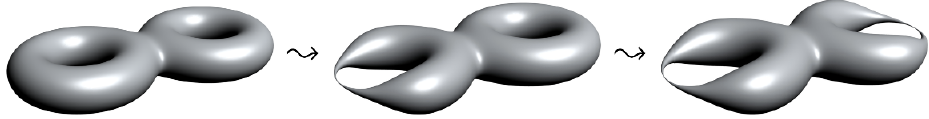
Figure 15 . A two-step residue argument relates an expression on the genus-two surface to an expression on the bi-nodal